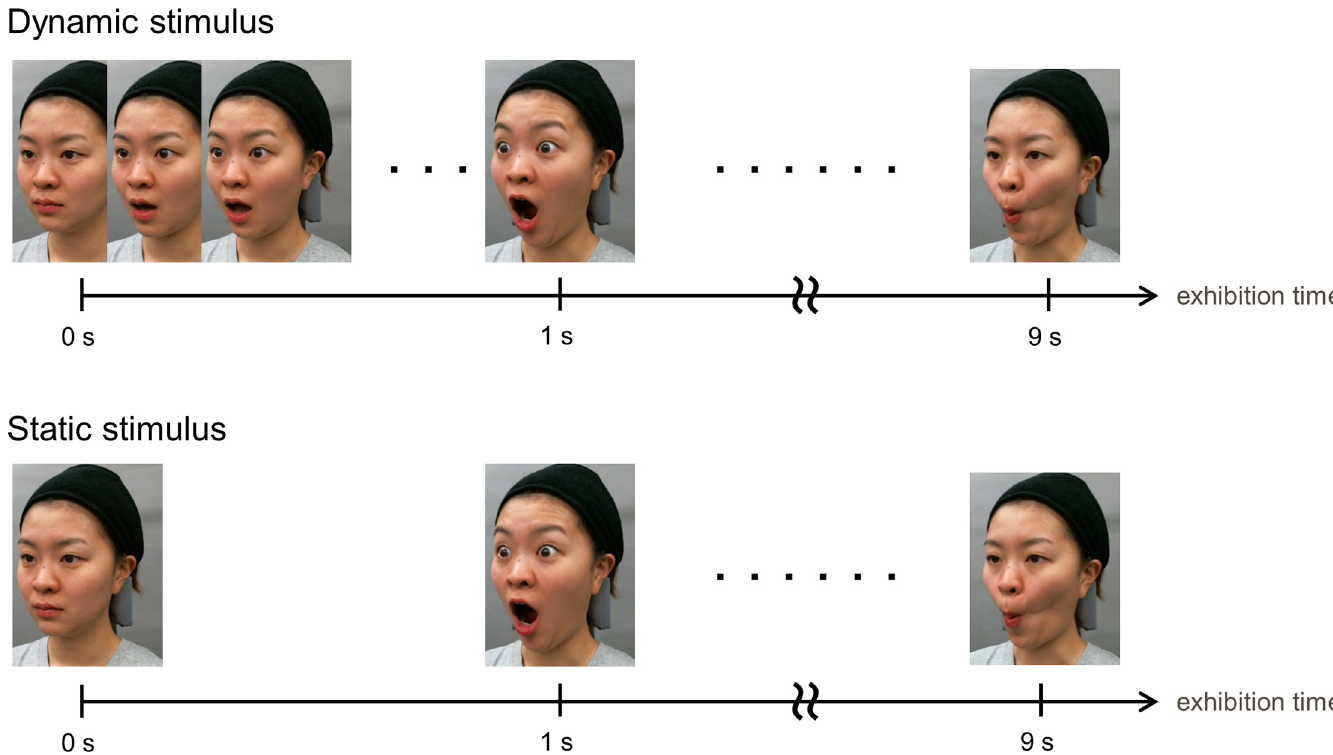
Fig 3. Two types of stimulus-conditions. Photographs show two stimulus-conditions: Dynamically moving expression shown by a nine-second video clip at a speed of 30 frames per second (fps) containing nine facial expression processes as the “dynamic stimulus,” and static facial expressions shown by nine static images taken from video files at the highest degree of facial expression, with a speed of 1 fps as the “static stimulus”.